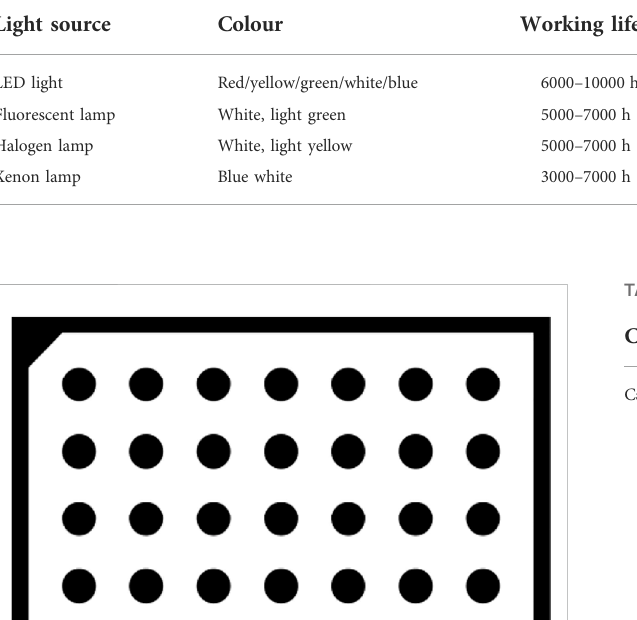
TABLE 2 Speci fi c properties of Common light Sources.